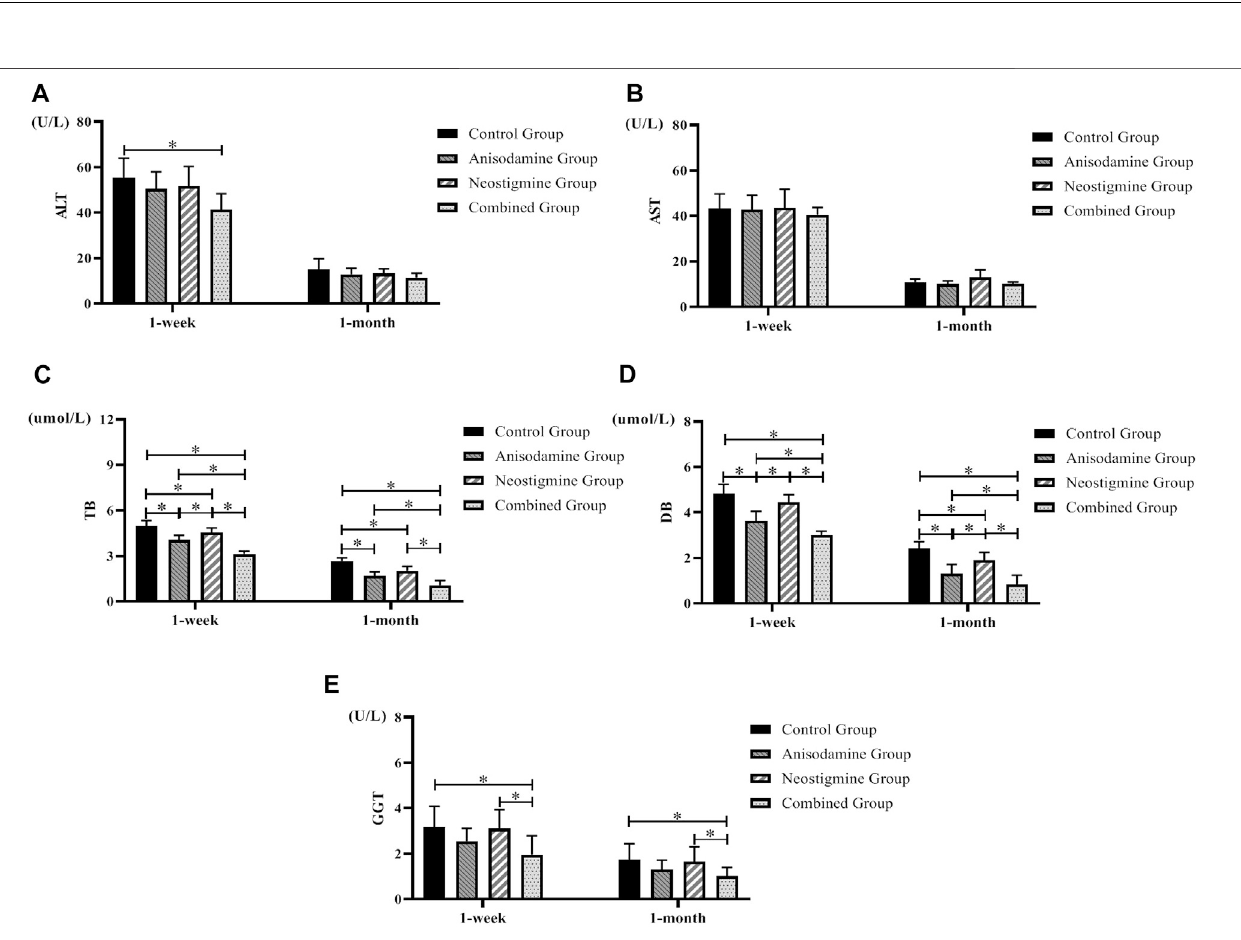
Frontiers in Pharmacology |